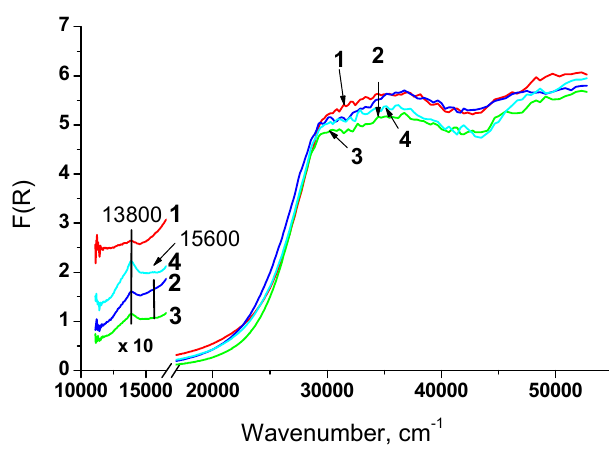
Figure 8. UV-Vis spectra of samples prepared in supercritical fluids: 1 – Ni-CeZr-sc, 2 – Ni-CeNbZr-sc, 3 – Ni-CeTiZr-sc, 4 – Ni- CeTiNbZr-sc.